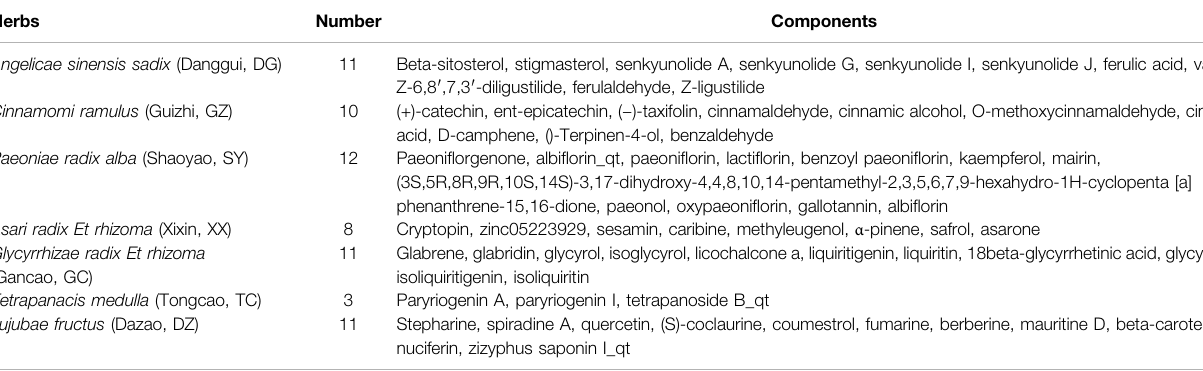
TABLE 1 | Active components identi fi ed in seven herbs of DSD. Herbs